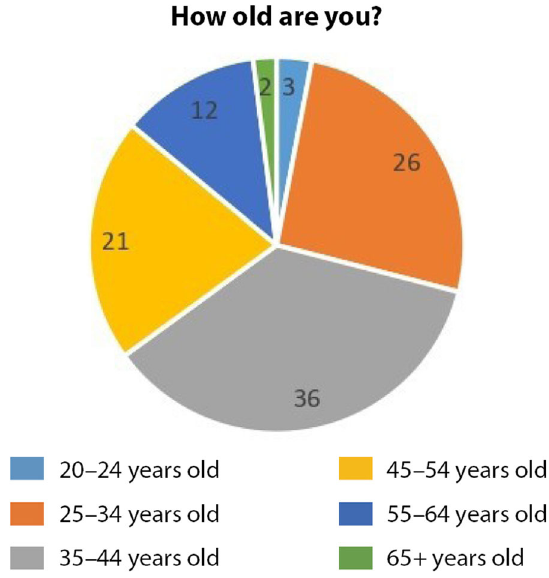
Fig. 3 respondents age-range distribution (Source: the authors)